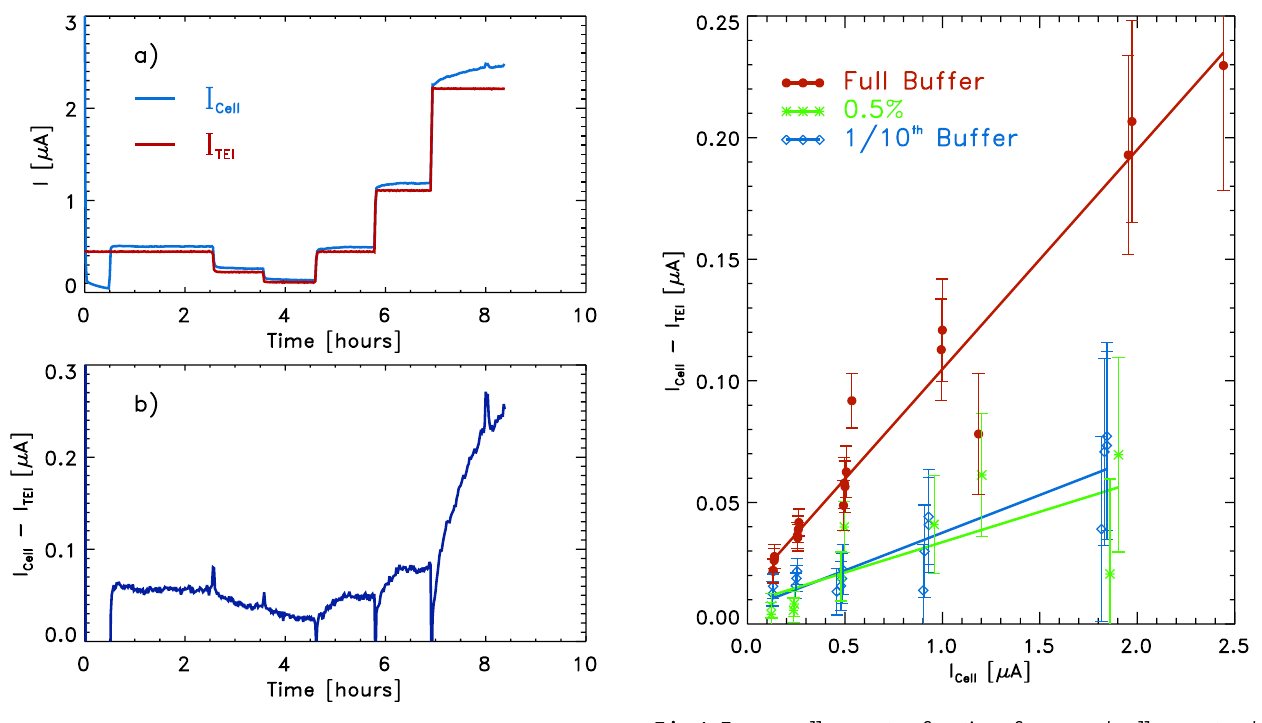
Fig. 3. Example of progression of ozone levels. (a) Measured cell current I cell and expected cell current I TEI . (b) Difference of mea- sured and expected cell current.